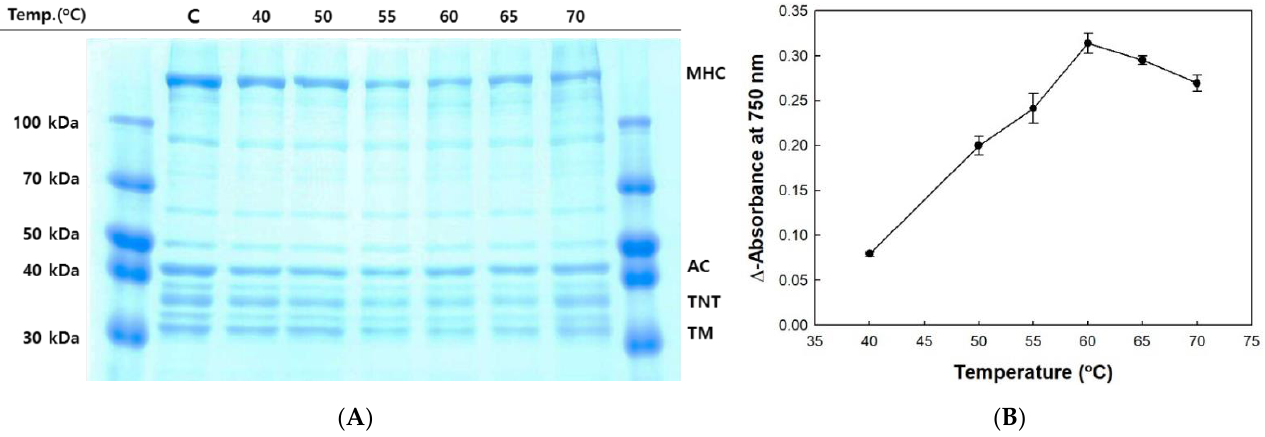
Figure 2. Autolytic pattern ( A ) and trichloroacetic acid (TCA)-soluble peptide content ( B ) of olive flounder paste with increasing temperature. Myosin heavy chain (MHC); actin (AC); troponin-T (TNT); tropomyosin (TM); control (C).